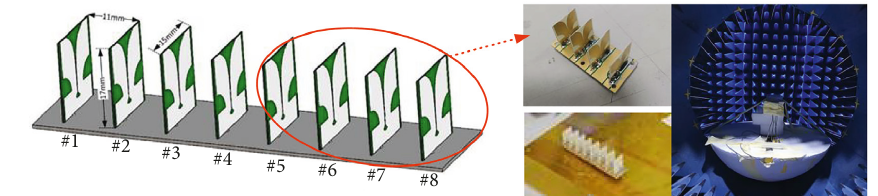
Figure 3: Model and physical prototype of phased array.